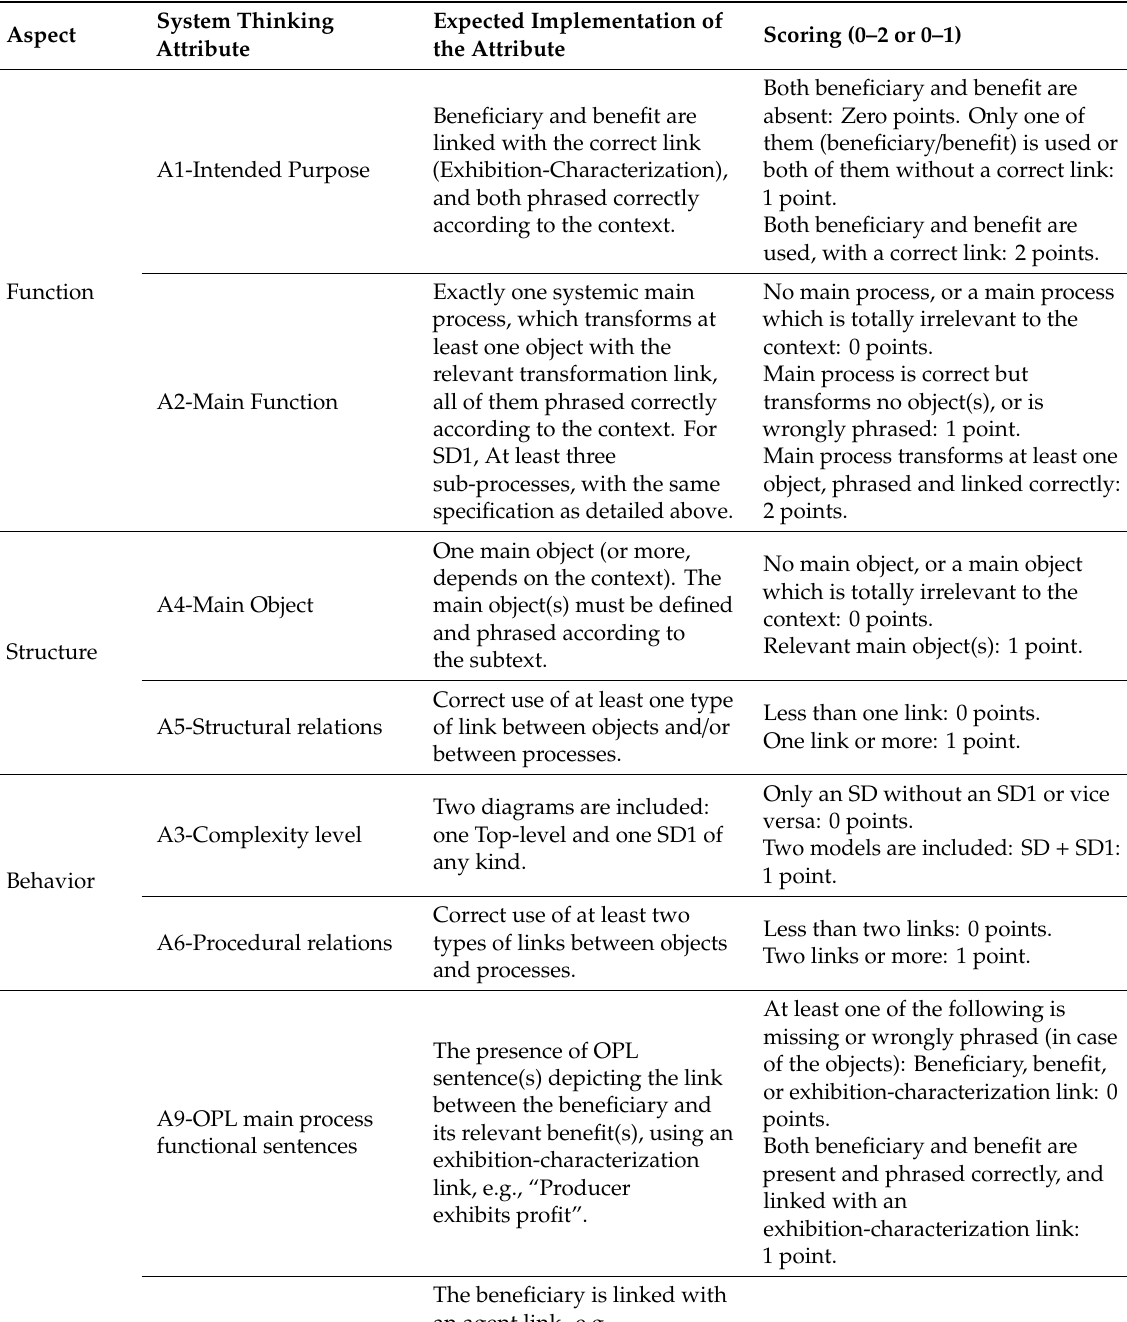
Table 4. Systems Thinking Assessment Rubric*